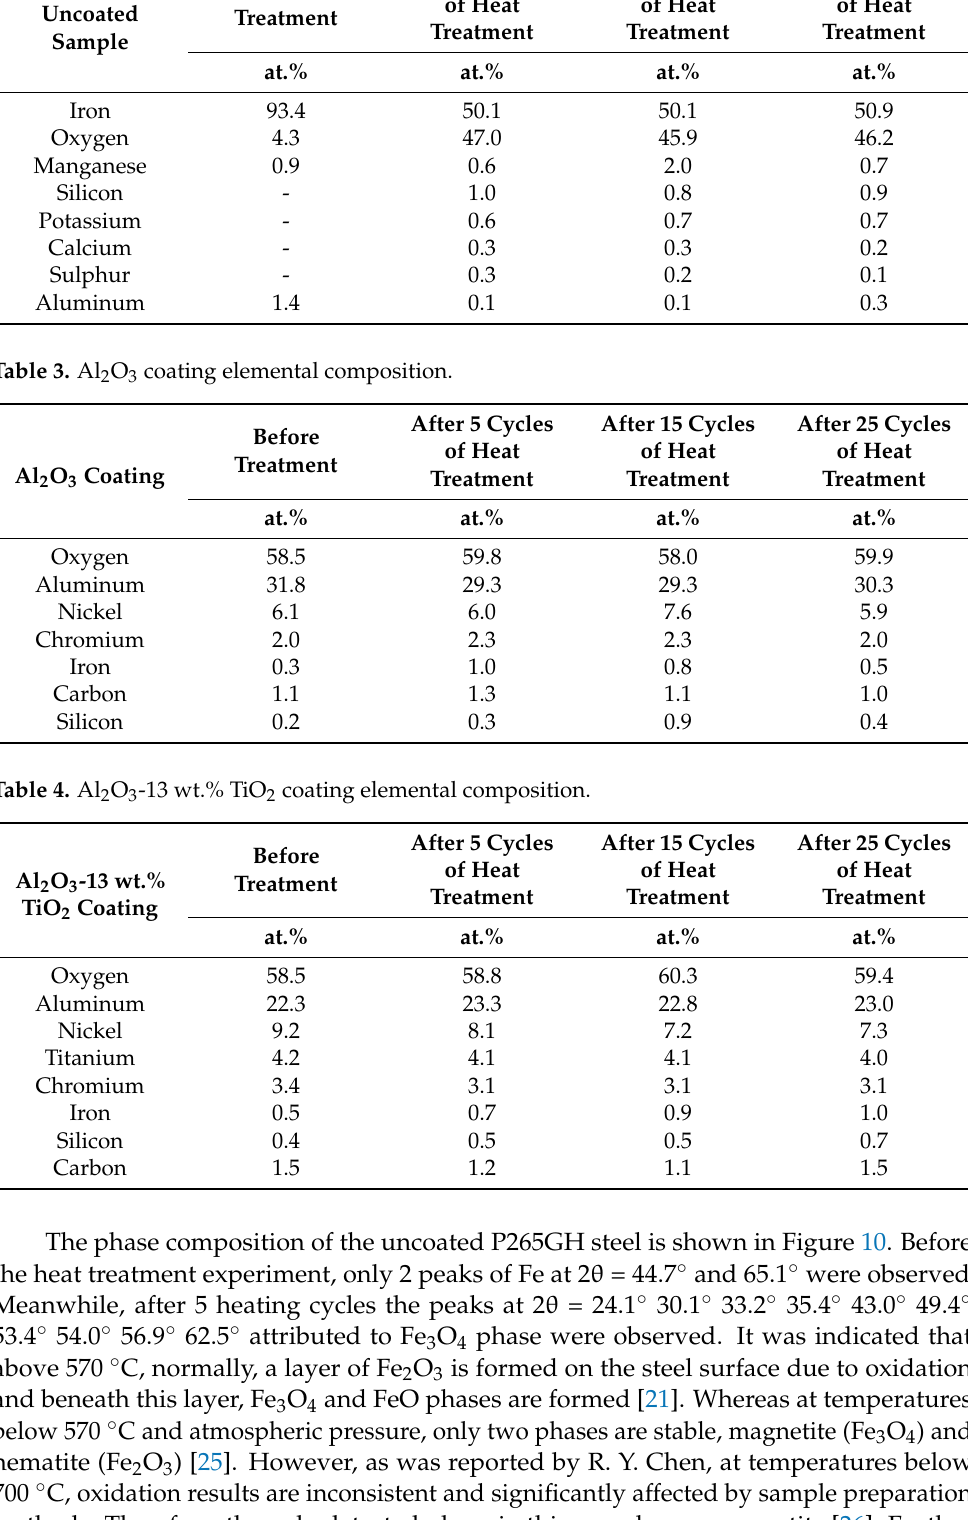
Table 2. Elemental composition of uncoated steel sample.